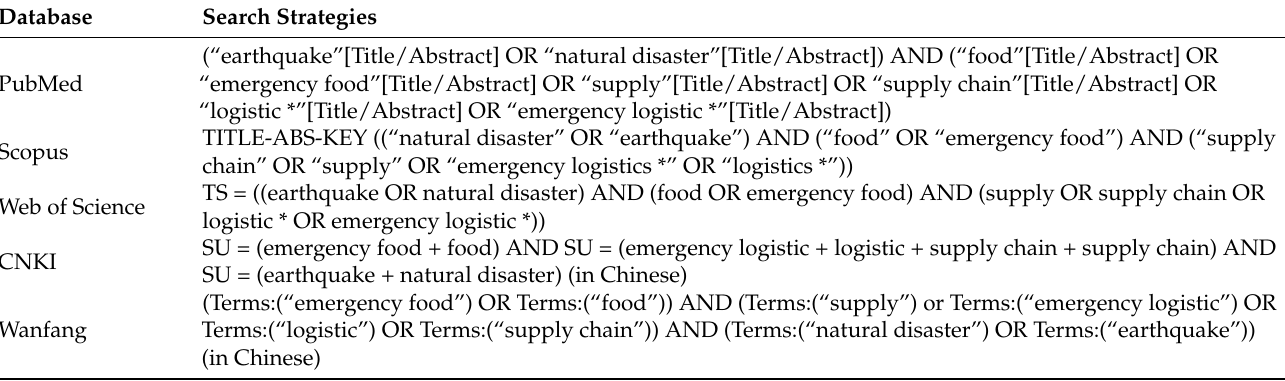
Table A1. Databases included in literature review and the search